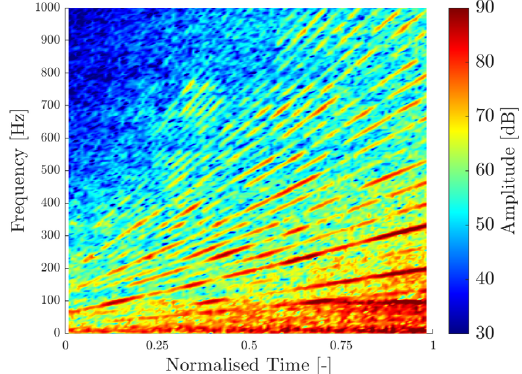
Figure 5. Normalised spectrogram of the sound pressure level measured at one of the headrest microphones during the WOT manoeuvre in the main